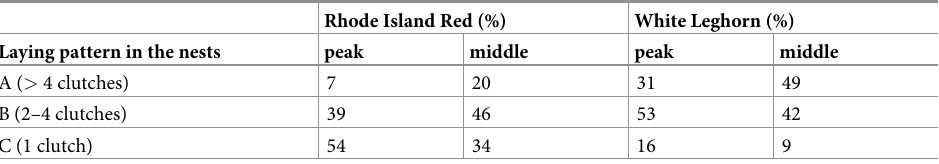
Relationships between recording periods for the same trait Most of the nest-related traits displayed a strong genetic correlation between the two periods despite modest phenotypic correlation (Table 6). In both lines, genetic correlations for MOT, MOI, and NAL between the peak and middle production were close to 1.00 (+0.84 to +0.97). Genetic correlations were strong for all other traits (+0.68 to +0.79). Phenotypic correlations were lower than estimated genetic correlations (+0.27 to +0.83). Table 3. Percentage of hens from Rhode Island Red and White Leghorn lines that displayed a given laying pattern in the nests at the peak and middle production. Rhode Island Red (%) White Leghorn (%) Laying pattern in the nests peak middle peak middle A ( > 4 clutches) 7 20 31 54 Data correspond to hens with a laying rate in the nests � 50% during the peak or middle production